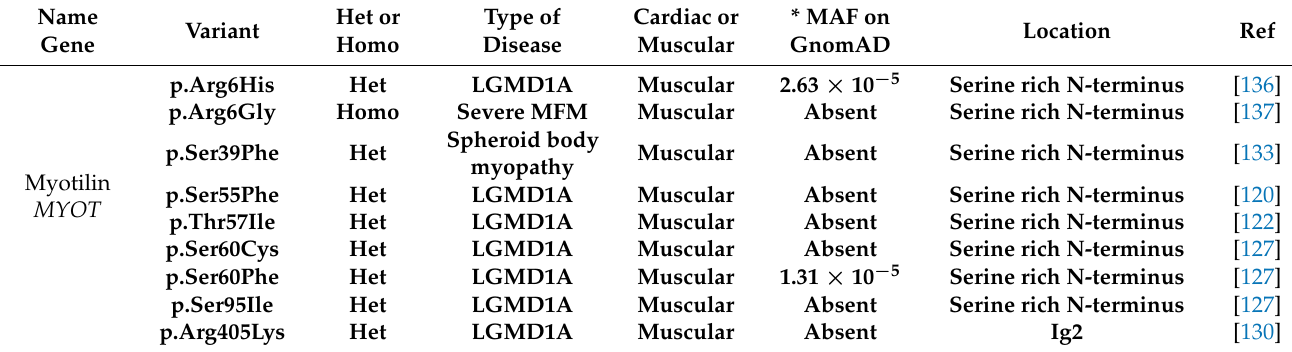
Table 4. Variants in the MYOT gene that have been previously reported in individuals with myopathy or